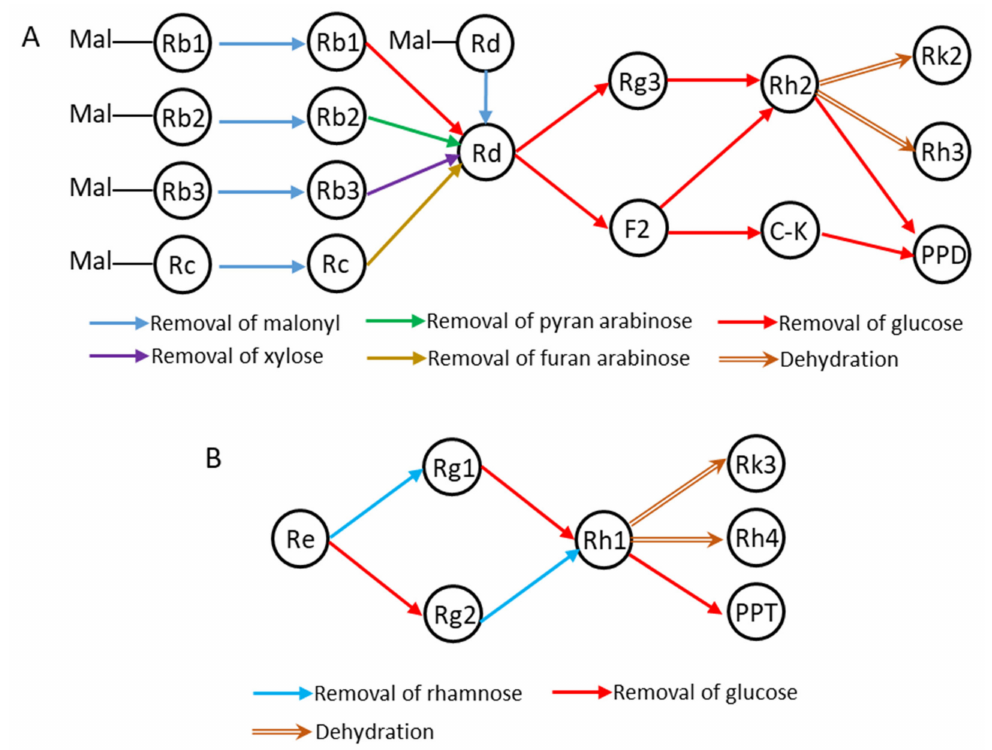
Figure 5. The transformation pathway of PPD-type ginsenosides ( A ) and protopanaxatriol (PPT)-type ginsenosides ( B ) during the steaming